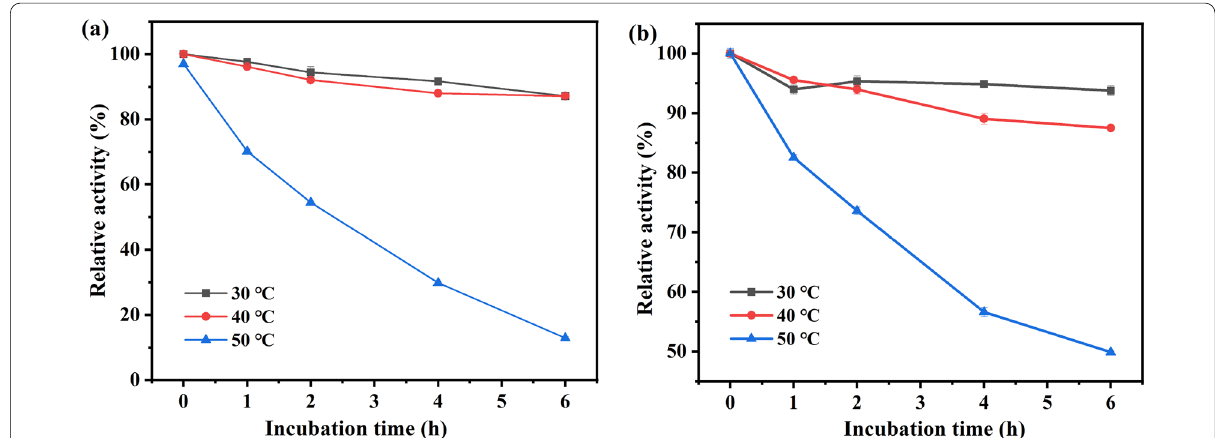
Fig. 2 Thermal stability of free ( a ) and alginate‑immobilized ( b ) recombinant E. coli cells. Reaction conditions: 4 mL Tris–HCl buffer (200 mM, pH 7.0), 100 mM MAA, 150 mM glucose, 30 mg/mL of free recombinant E. coli cells (wet weight), or alginate‑immobilized cells containing the same amount of free cells, 40 °C, 200 rpm